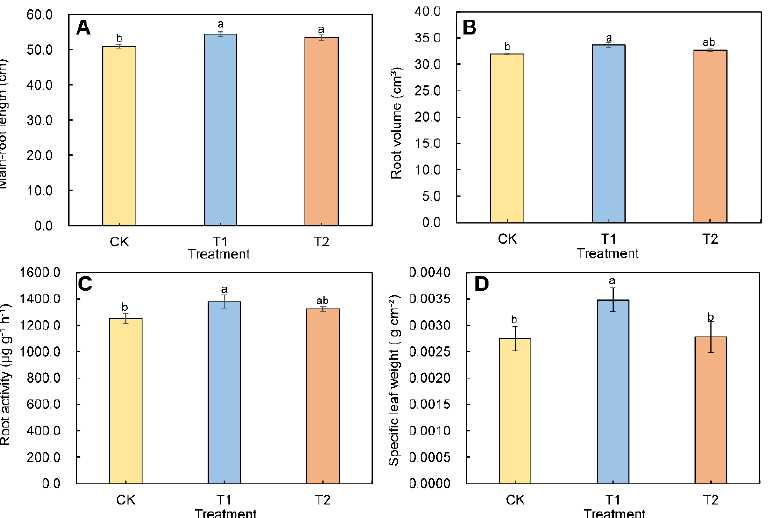
Figure 4. Length of main root ( A ), root volume ( B ), root activity ( C ), and specific leaf weight ( D ) of tomato plants exposed to different LED light supplementation durations. Data are expressed as average values ( n = 3). Different lowercase letters indicate significant differences between treatments determined using Duncan’s multiple range test ( p < 0.05). Standard errors are indicated by bars. CK: no light supplementation or control; T1: light supplementation for 3 h in the morning; T2: light supplementation for 3 h in the evening.